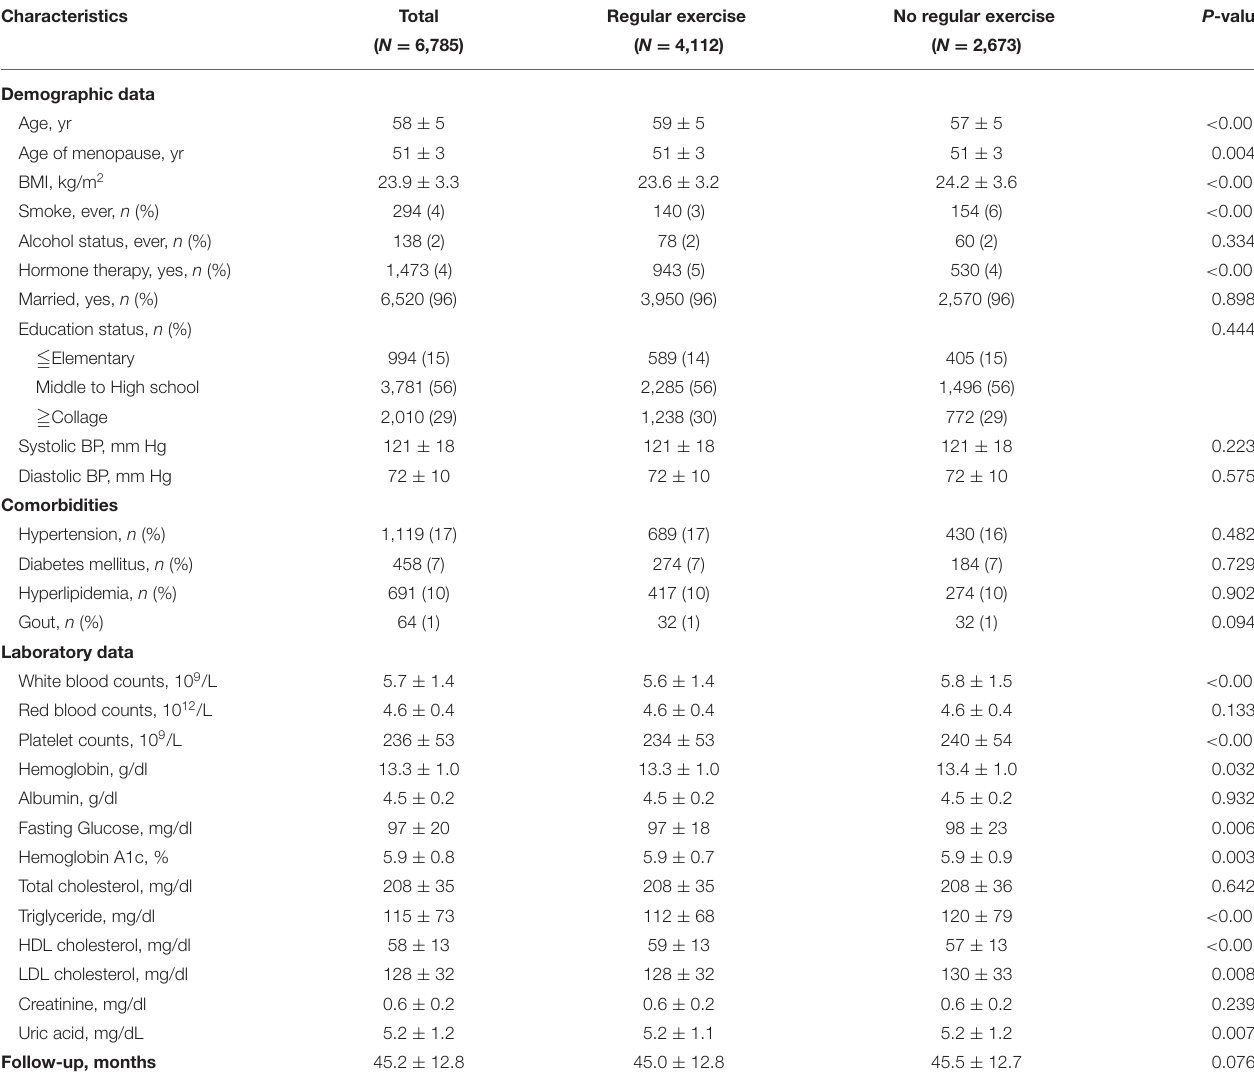
TABLE 4 | General characteristics of postmenopausal women in the longitudinal cohort ( N = 6,785).